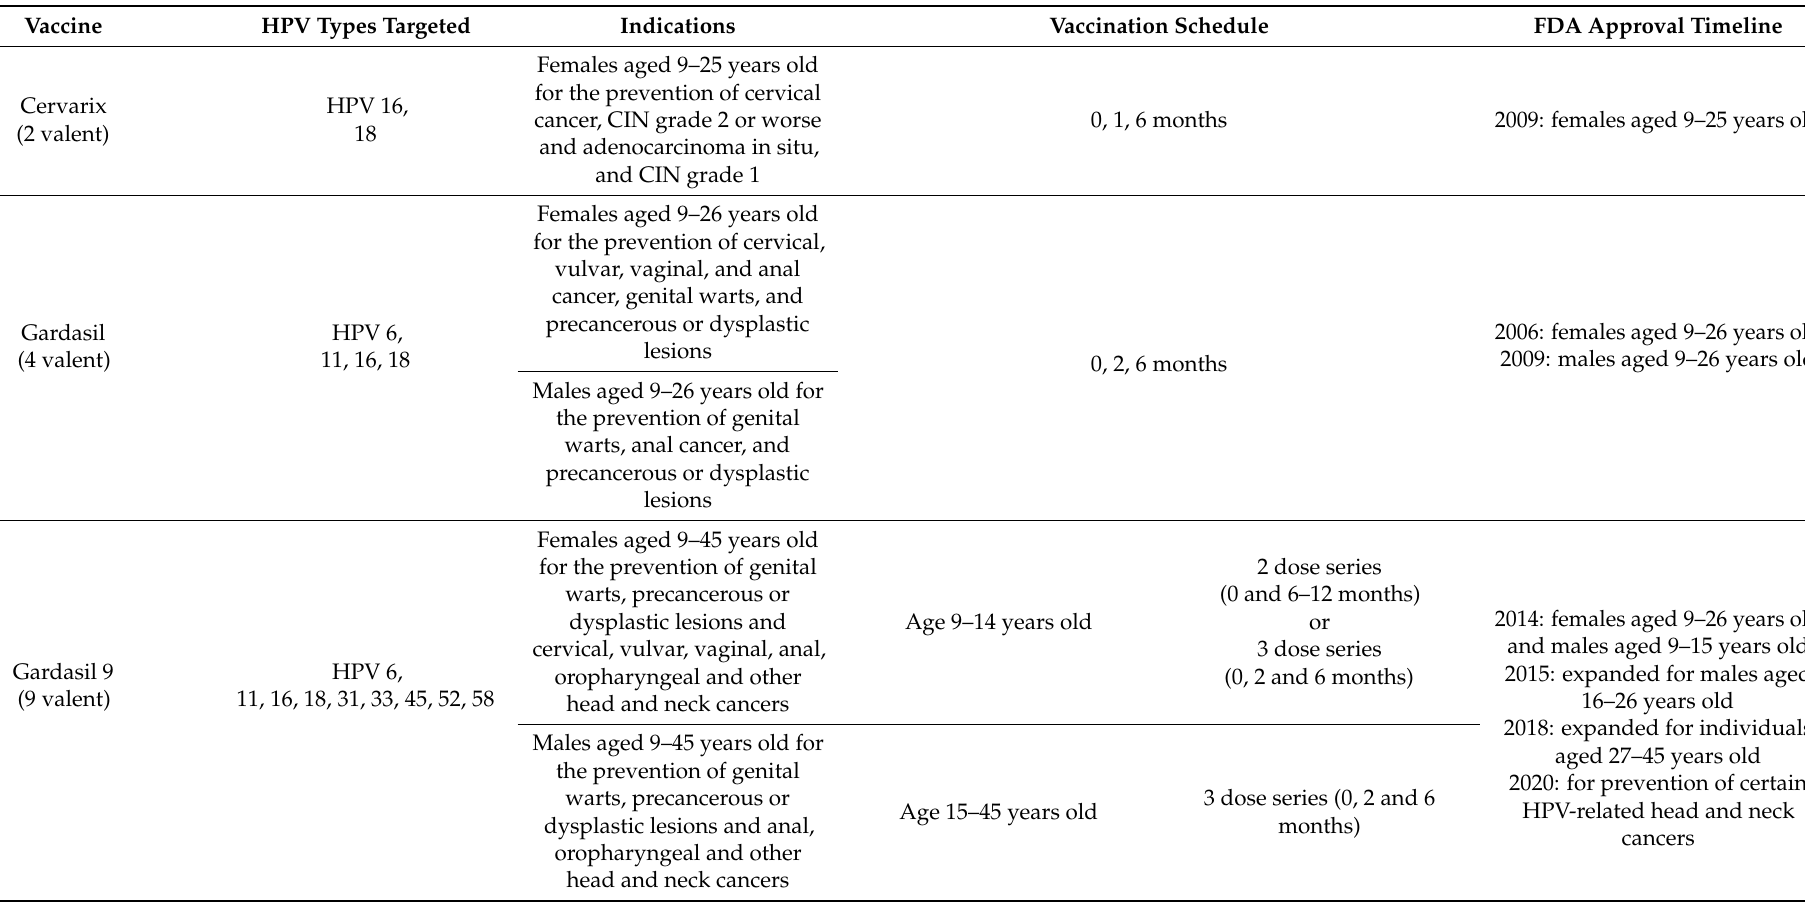
Table 1. Comparison of current available prophylactic HPV